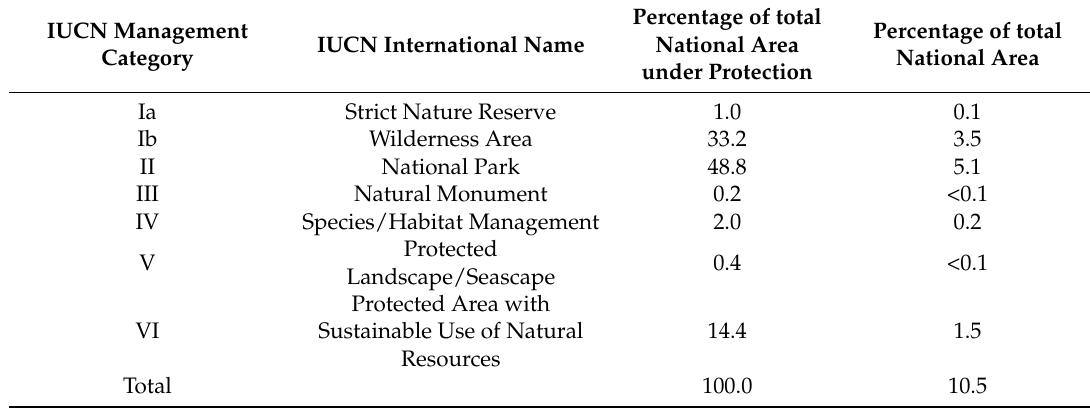
Table 4. Protected areas (PAs) in Canada, by IUCN